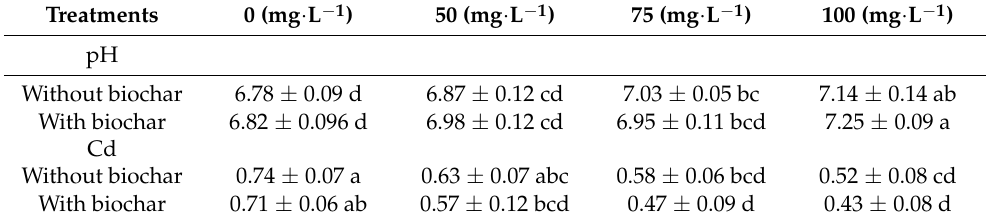
Figure 4. Effects of foliar-applied ZnO NPs alone and combined with bamboo biochar on ( A ) Cd in shoot, ( B ) Cd in root, ( C ) Cd in grain, ( D ) Zn in shoot, ( E ) Zn in shoot, and ( F ) Zn in grain. Different letters on the bars demonstrate the significant differences between treatments at p ≤ 0.05. In the figures: ns: non-significant; * significant at 0.05, ** significant at 0.01, and *** significant at 0.001 levels. Table 2. Postharvest soil AB-DTPA-extractable Cd (mg · kg − 1 ) and pH. Values are means of five replications, and different letters demonstrate significant differences between treatments at p ≤